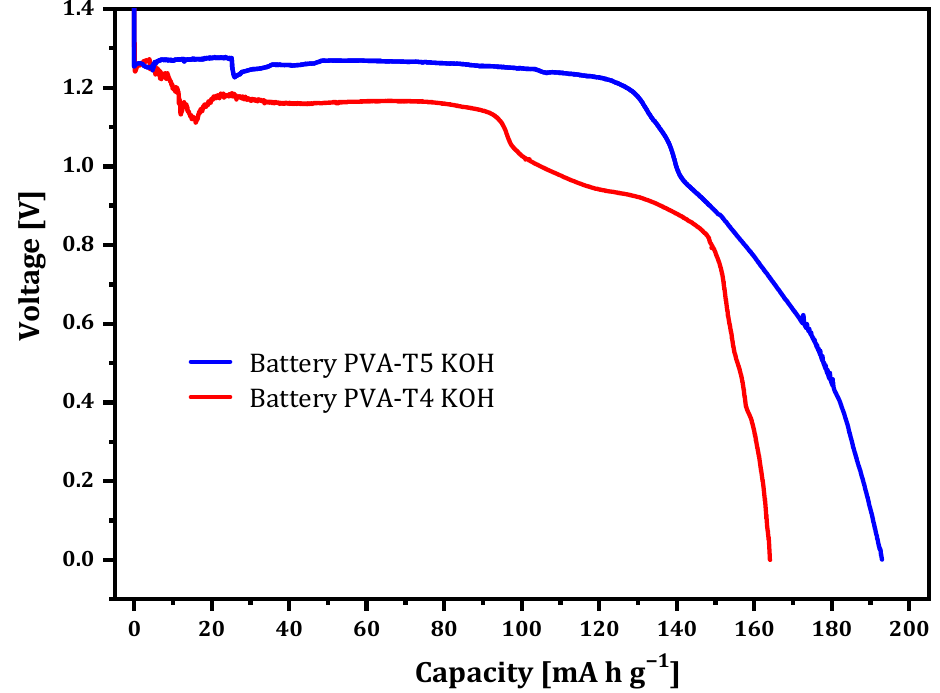
Figure 11. Discharge curves of Zn/PVA-T4 KOH/Air, Zn/PVA-T5 KOH/Air. Zn-air batteries using PVA-VAVTD GPEs present a capacity of 135 mAh/g and 150 mAh/g for PVA-T4 KOH and PVA-T5 KOH, respectively, with a cut-off voltage of 0.9 V.